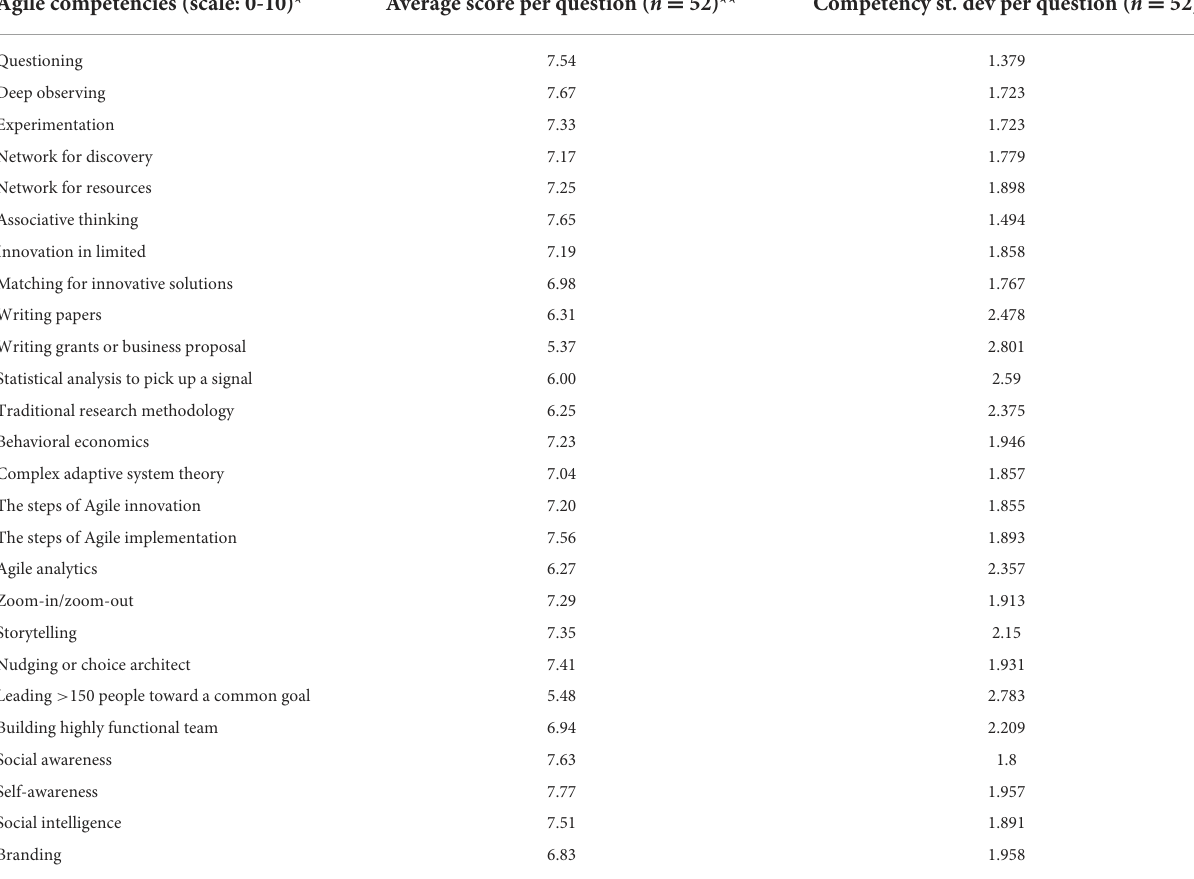
TABLE 2 Agile competency following course completion. Agile competencies (scale: 0-10)* Average score per question ( n =